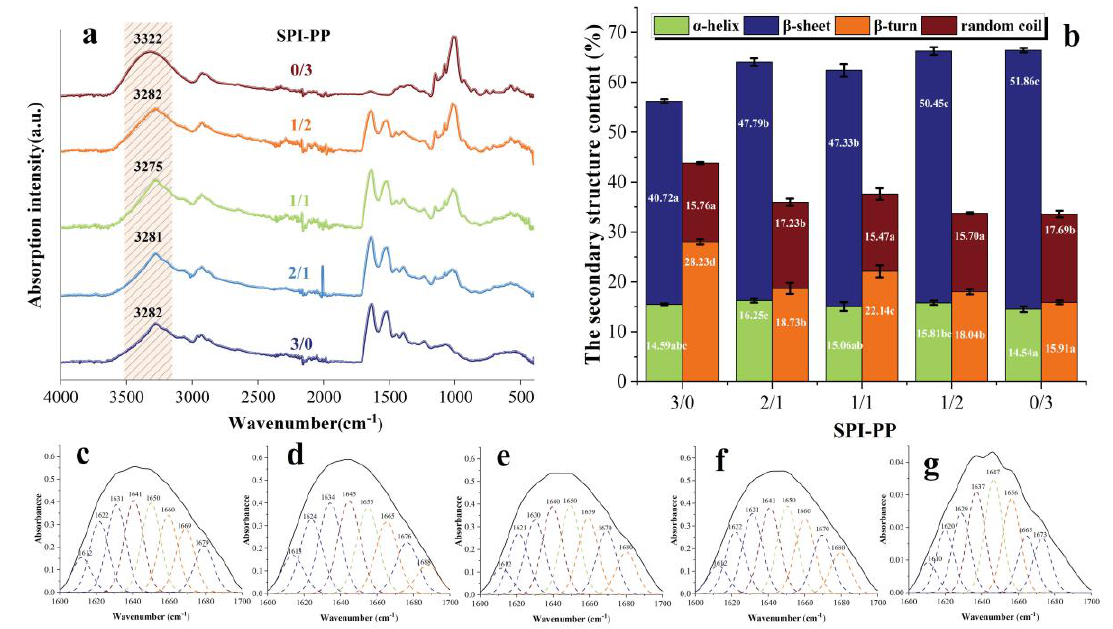
Figure 5. FT − IR spectra of gel samples. ( a ) Secondary structure content of composite gels at different SPI and PP ratios; ( b ), the fitting peaks of the infrared spectra of gels (1700 − 1600 cm − 1 ); ( c )SPI − PP = 3/0; ( d ) SPI − PP = 2/1; ( e ) SPI − PP = 1/1; ( f ) SPI − PP = 1/2; and ( g ) SPI − PP = 0/3. Different lowercase letters in the figure indicate significant differences between samples in the same group ( p < 0.05).